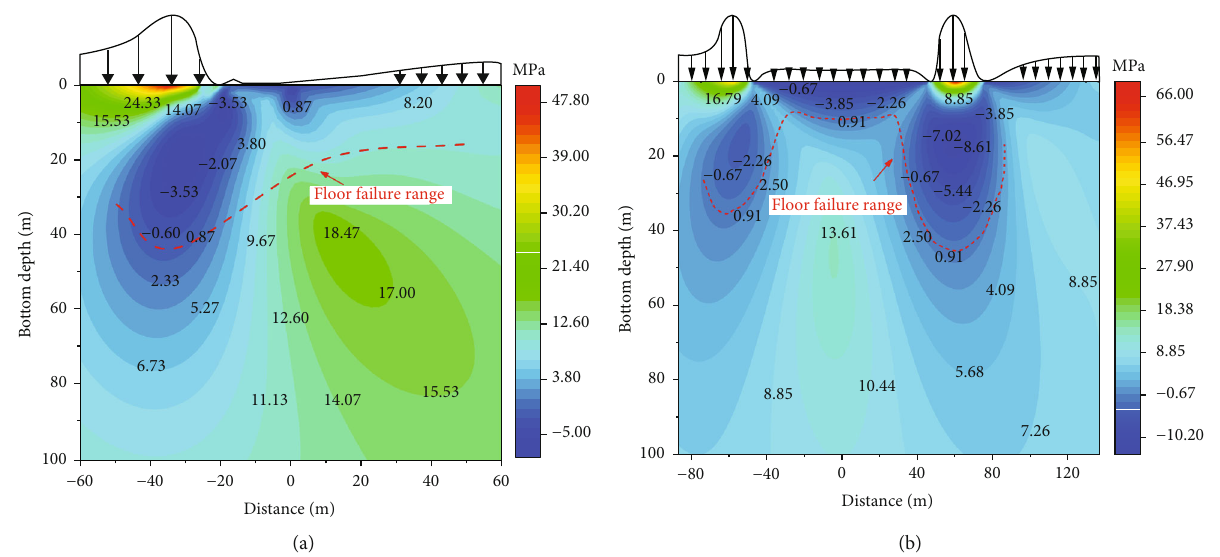
Figure 9: The fl oor failure zones: (a) along the inclination; and (b) along the